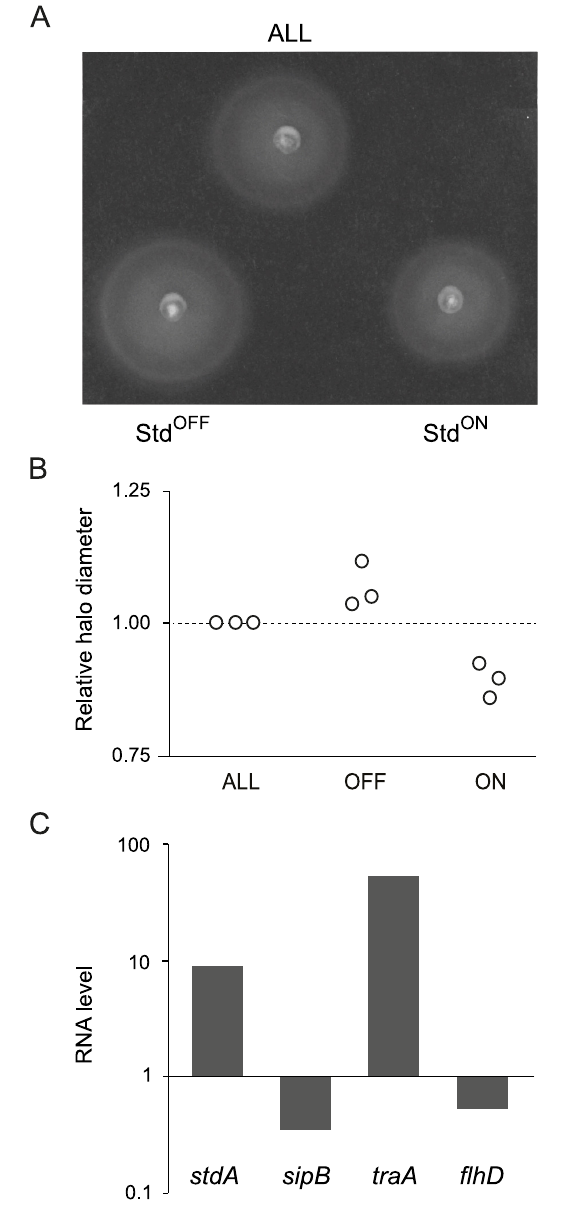
Fig 7. Analysis of lineage-specific traits upon cell sorting. A. Motility of sorted cells (Std OFF and Std ON subpopulations) and of the whole bacterial population (ALL). The experiments were performed in triplicate, and a representative experiment is shown. B. Relative diameter of motility halos from 3 independent experiments. Data are normalized to the halo diameter obtained in the whole bacterial population (ALL) which was set to "1" in all cases. C. RNA levels detected by RT-PCR upon magnetic-activated cell sorting (MACS) of Std OFF and Std ON cell lineages. For each locus, data are normalized to the RNA level obtained in the Std OFF population (which was set to "1" in all cases). RNA levels were determined for 3 replicates, and a representative experiment is